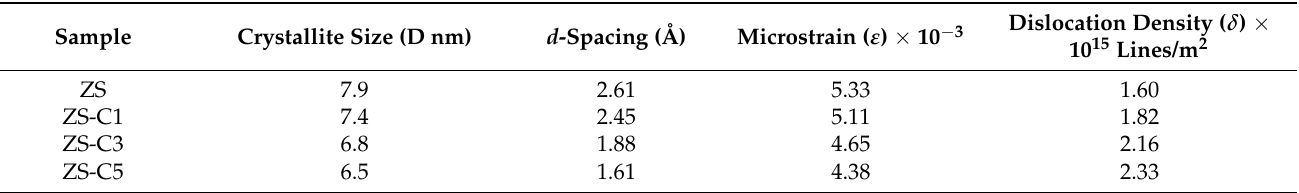
Table 1. Average crystallite size, d -spacing, microstrain, and dislocation density of undoped and Cu 2+ -doped ZnO–SnS